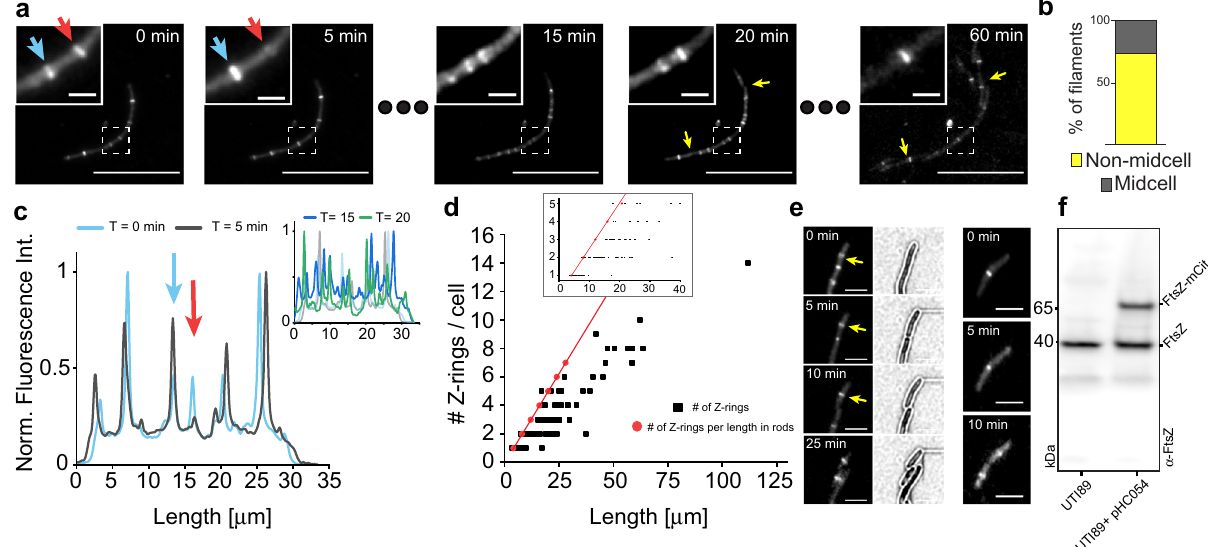
Fig. 3 FtsZ-mCitrine localization and dynamics in fi laments. To visualize Z-rings in fi laments, UTI89 cells were transformed with a plasmid producing FtsZ-mCitrine (pHC054) and run through the UTI model. a Still images from a representative time-lapse of a fi lament undergoing reversal (Supplementary movie SM7). Inset show a magni fi ed view of the dashed square (Supplementary movie SM8), blue arrow indicates a FtsZ-mCitrine ring that increase in intensity from t = 0 to t = 5, red arrow indicates a FtsZ-mCitrine ring that completely disassembles during the same time. Yellow arrows at t = 20 indicate the fi rst divisions. Scale bar 20 μ m. b Percentage of fi laments in which fi rst division was at midcell vs non-midcell (towards the poles). c Normalized fl uorescence intensity traces at various time points from the fi lament in a . Blue and red arrows correspond to the blue and red arrows in a . Inset show traces at t = 15 (dark blue) and t = 20 min (green), light blue and grey are the traces from earlier timepoints. d Filaments have less Z-rings assembled than the corresponding rods would have per cell length. Black squares show the number of FtsZ-mCitrine rings in fi laments at the start of the imaging. Red dots indicate the corresponding number of ‘ expected ’ Z-rings assuming one ring per WT cell length (i.e., one ring per ~4 μ m). Inset shows magni fi cation of fi laments in lengths up to 40 μ m. n = 100. e The presence of rod-shaped cells after infection indicated that FtsZ-mCitrine did not in fl uence division (nor induced fi lamentation). Left column: FtsZ-mCitrine was pre-assembled in ‘ cells ’ before they separated from the mother fi lament. Scale bar 4 μ m. f Western blot indicating the FtsZ protein levels in fi laments. The total production of the FtsZ-mCitrine was 43 ± 1% of the total cellular FtsZ pool ( n = 3). All times in time lapses indicate time relative to fi rst image ( t = 0 min). Source data are provided as a Source data fi